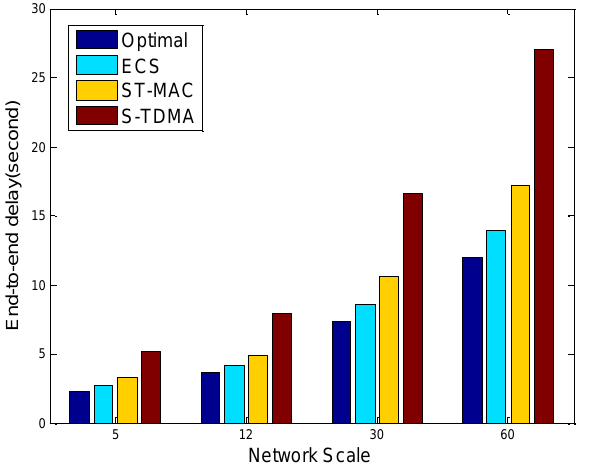
Figure 8. End-to-end delay of different TDMA